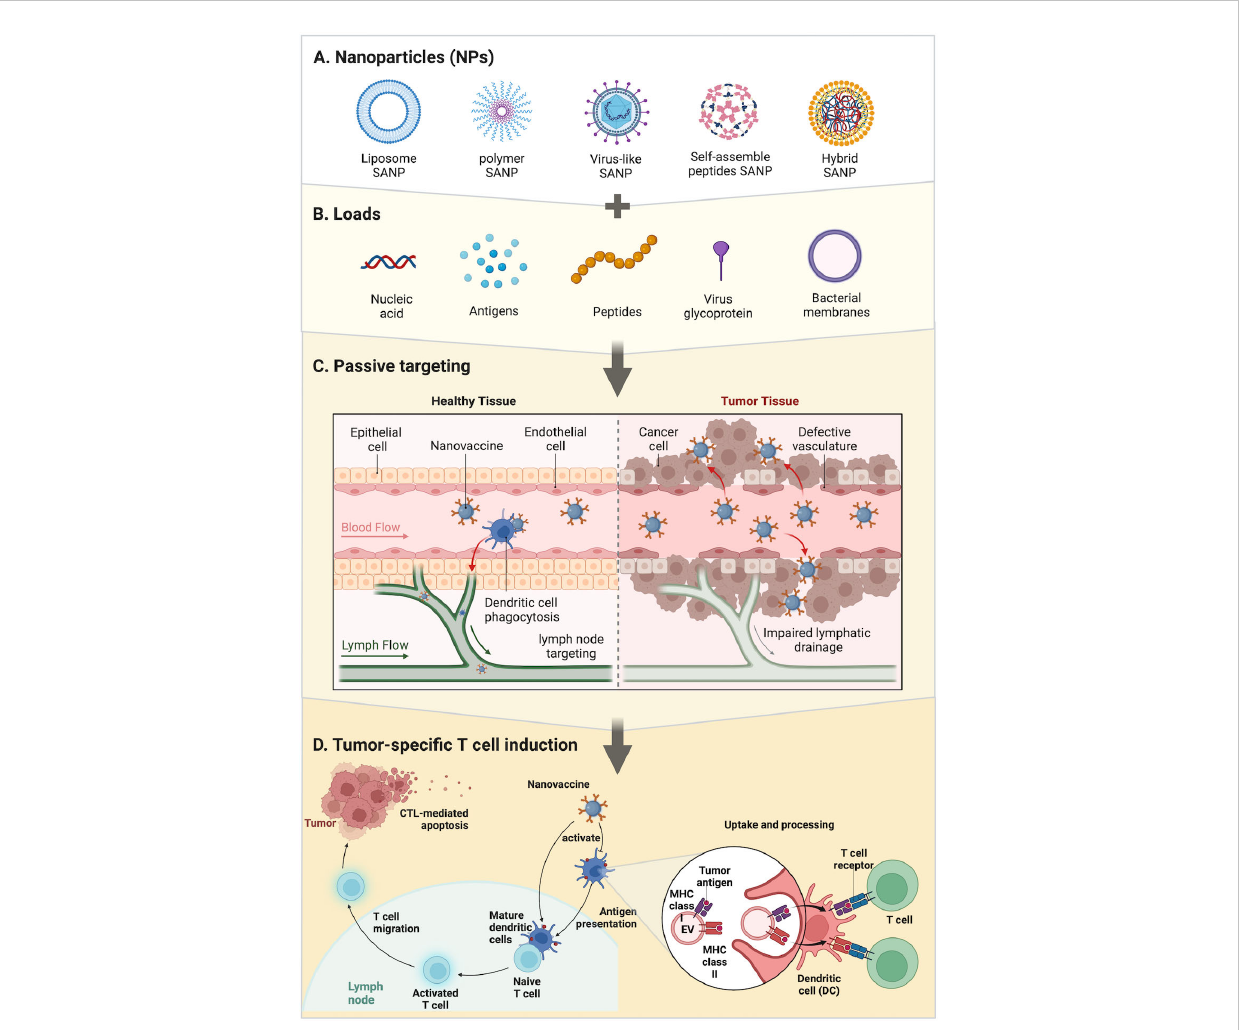
FIGURE 1 Strategies of SANPs: (A) SANPs based on multiple materials. (B) During the synthesis of SANPs, antigens or other immune activators can be loaded onto SANPs by chemical modi fi cation or physical packaging. Nucleic acids and antigens can be physically embedded in liposome and polymer SANPs; bacterial membrane can wrap around SANPs ’ surface; virus glycoprotein and peptides are loaded into viral particles or peptide chains through autonomous synthesis, as well as antigens. (C) SANP-based nanovaccines targeting SANPs were injected intravenously into the bloodstream and circulate throughout the body to activate dendritic cells and recruit T cells around lymph nodes and tumor tissue. (D) Tumor-speci fi c T-cell induction: SANPs can induce cytotoxic T lymphocytes by activating peripheral dendritic cells (DCs) that then present antigens to T cells in lymph nodes, or SANPs can directly target lymph nodes for induction within lymph nodes. Nanovaccines deliver antigens and adjuvants to DCs, which subsequently upregulate co-stimulatory molecules and present the processed antigen to T cells via MHC-II molecules. DCs can directly activate T cells by MHC-bound antigens and costimulatory molecules present on cell-derived membranes on the surface of